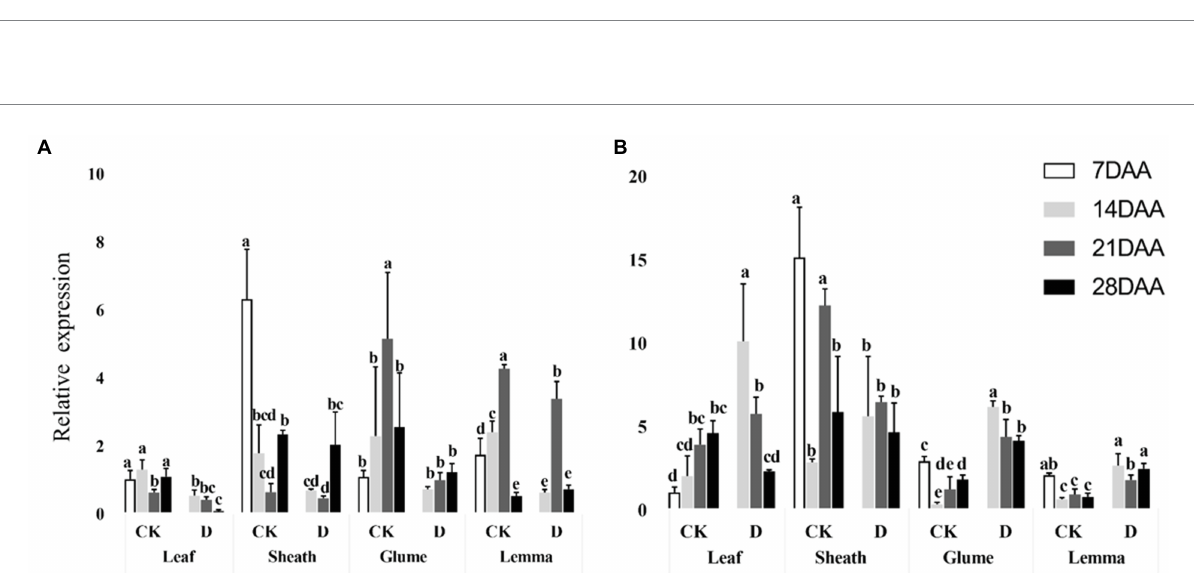
FIGURE 5 Relative expression of PEPC gene (A) and MDH gene (B) in different organs under control and drought stress. Different small letters within the same organ meant a significant difference at the 0.05 probability